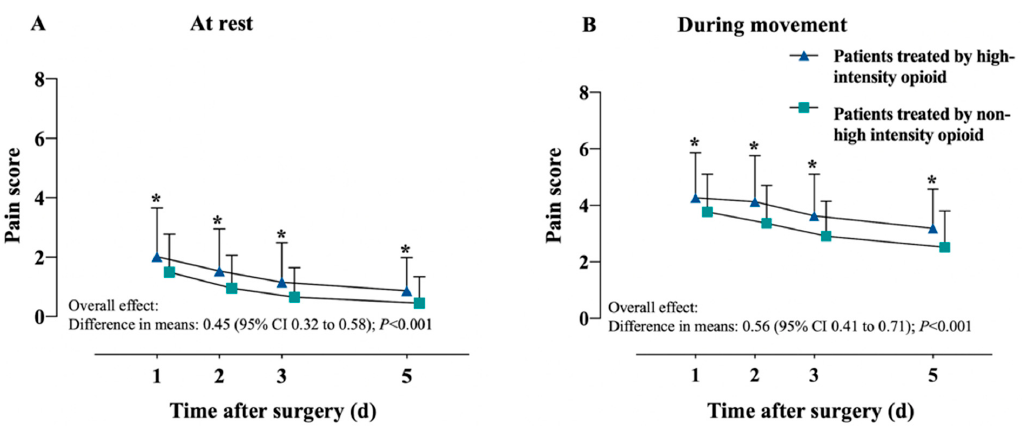
Figure 2. Average postoperative pain scores ( A ) during movement or ( B ) at rest. * p < 0.001. Abbreviations: CI, confidence interval. Cyan represents patients treat by “high-intensity” opioid; Light green represents patients treated by “non-high-intensity” opioid. Table 2. Generalized estimating equation model to identify associations between intensity of postoperative opioid use and pain scores at rest and during movement.